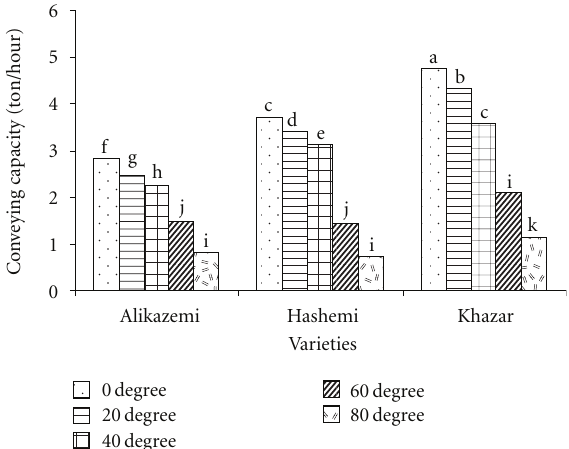
Figure 5: Mean comparison results of interaction e ff ects of variety and conveyor inclination angle on the conveying capacity (dissimilar letters show di ff erent significantly at probability level %5).